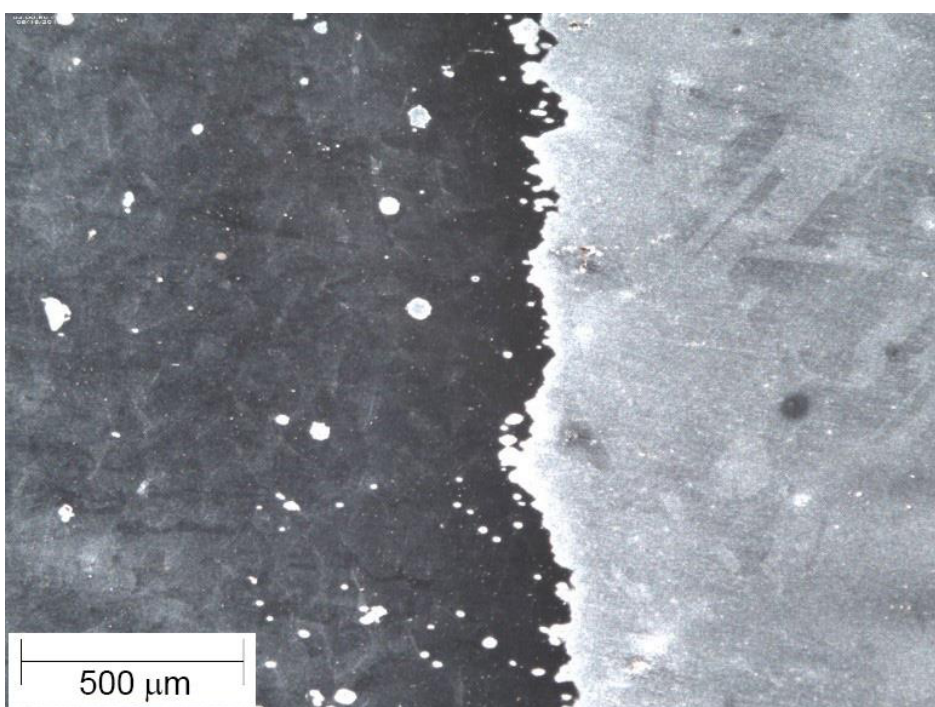
Figure 7. SS316L PBF/wrought interface (63× magnification). EBSD scans provided images of the grain structure and the average grain size calculations. Calculated grain sizes for the wrought and PBF materials are shown in Table 6, with grain maps for each material shown in Figure 8. Table 6. EBSD grain map analysis.